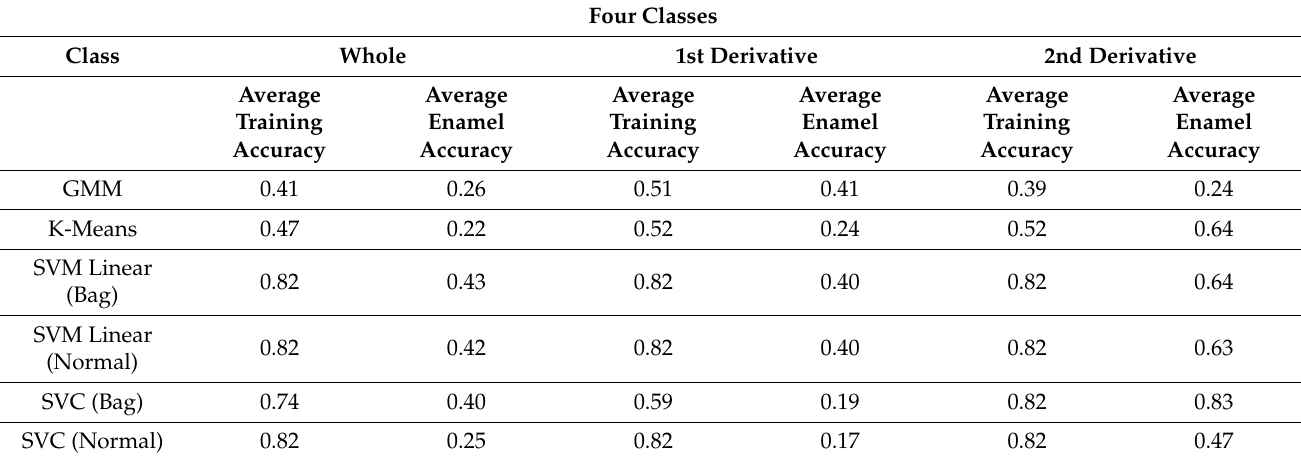
Table 2. Average training and enamel classification accuracy for each trained model type for four